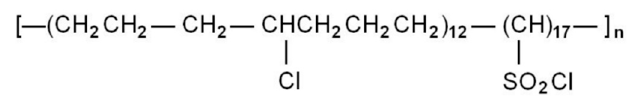
Figure 1. Formula of chlorosulfonated